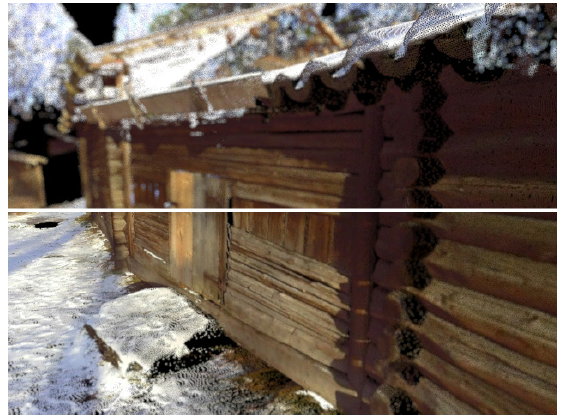
Figure. 5 Testing different amplitude of Depth of Field in Mental Ray through ‘Camera Effects